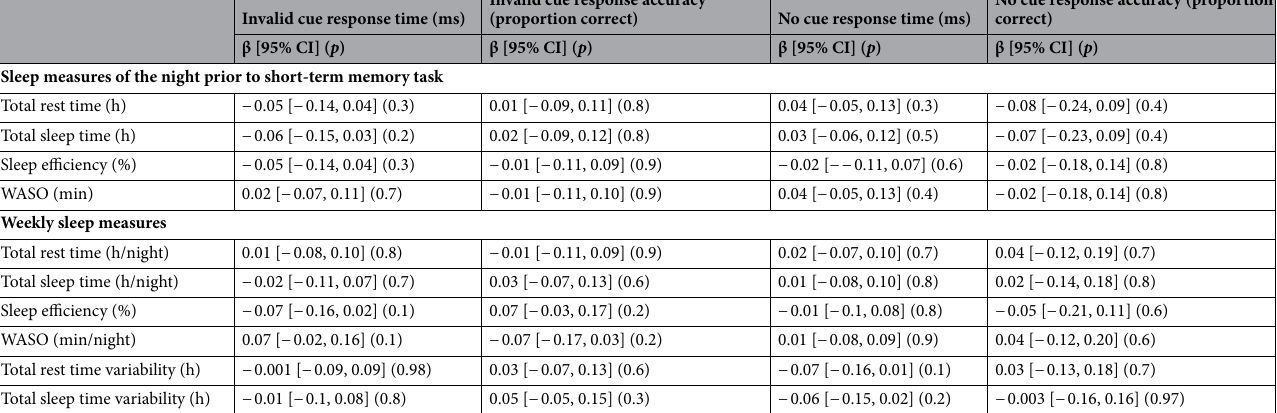
Table 5. Results of linear regression between sleep parameters and response times and accuracies on the visual attention task. All regressions adjusted for clinical diagnosis of attention deficit hyperactivity disorder and reported weekly video game use. Invalid cue and no cue response time additionally adjusted for valid cue response times. Invalid cue and no cue response accuracy additionally adjusted for valid cue response accuracy. Response times, response accuracies, sleep efficiency, total sleep time variability, and total rest time variability were transformed prior to analysis due to skewed distributions. β, standardized beta value; CI, confidence interval; WASO, wake time after sleep